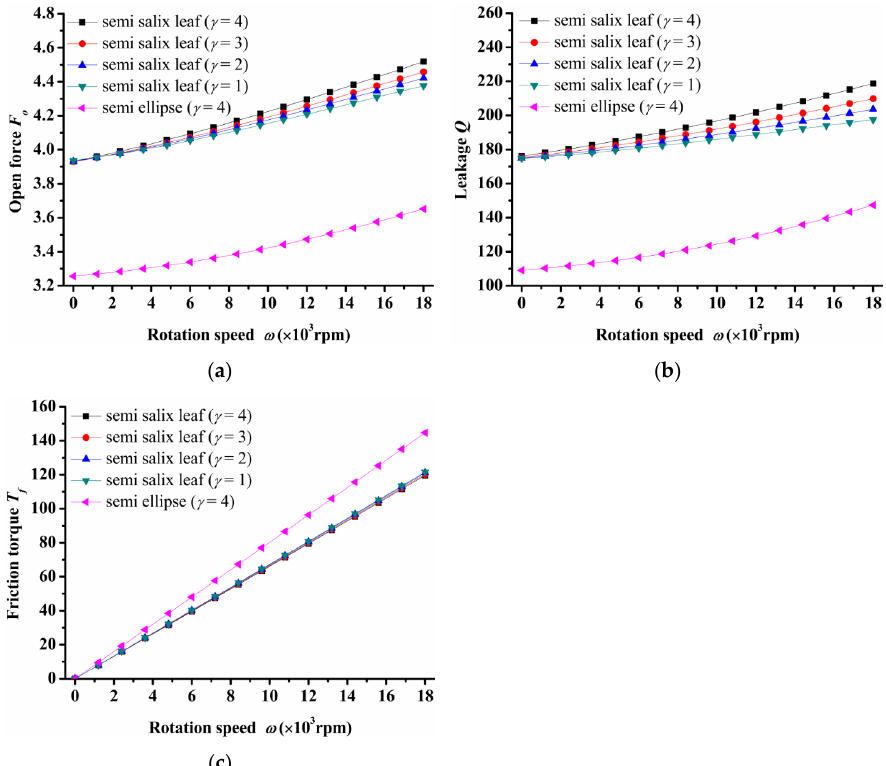
Figure 4. Influence of rotation speed on seal performance: ( a ) opening force, ( b ) leakage, ( c ) friction torque.